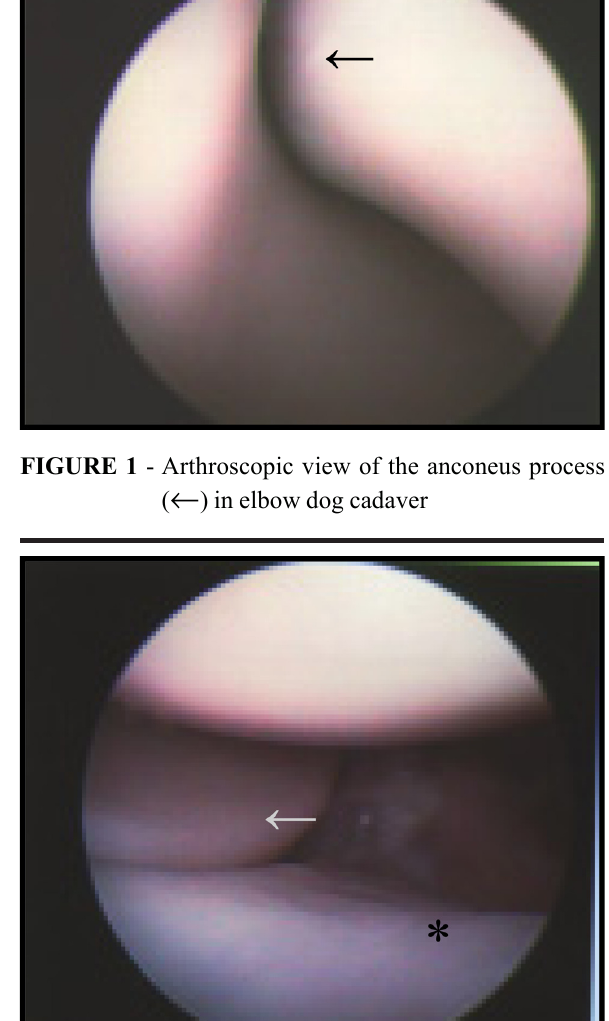
FIGURE 2 - Arthroscopic view of the radial head ( the medial coronoid process of the ulna (*) in elbow dog